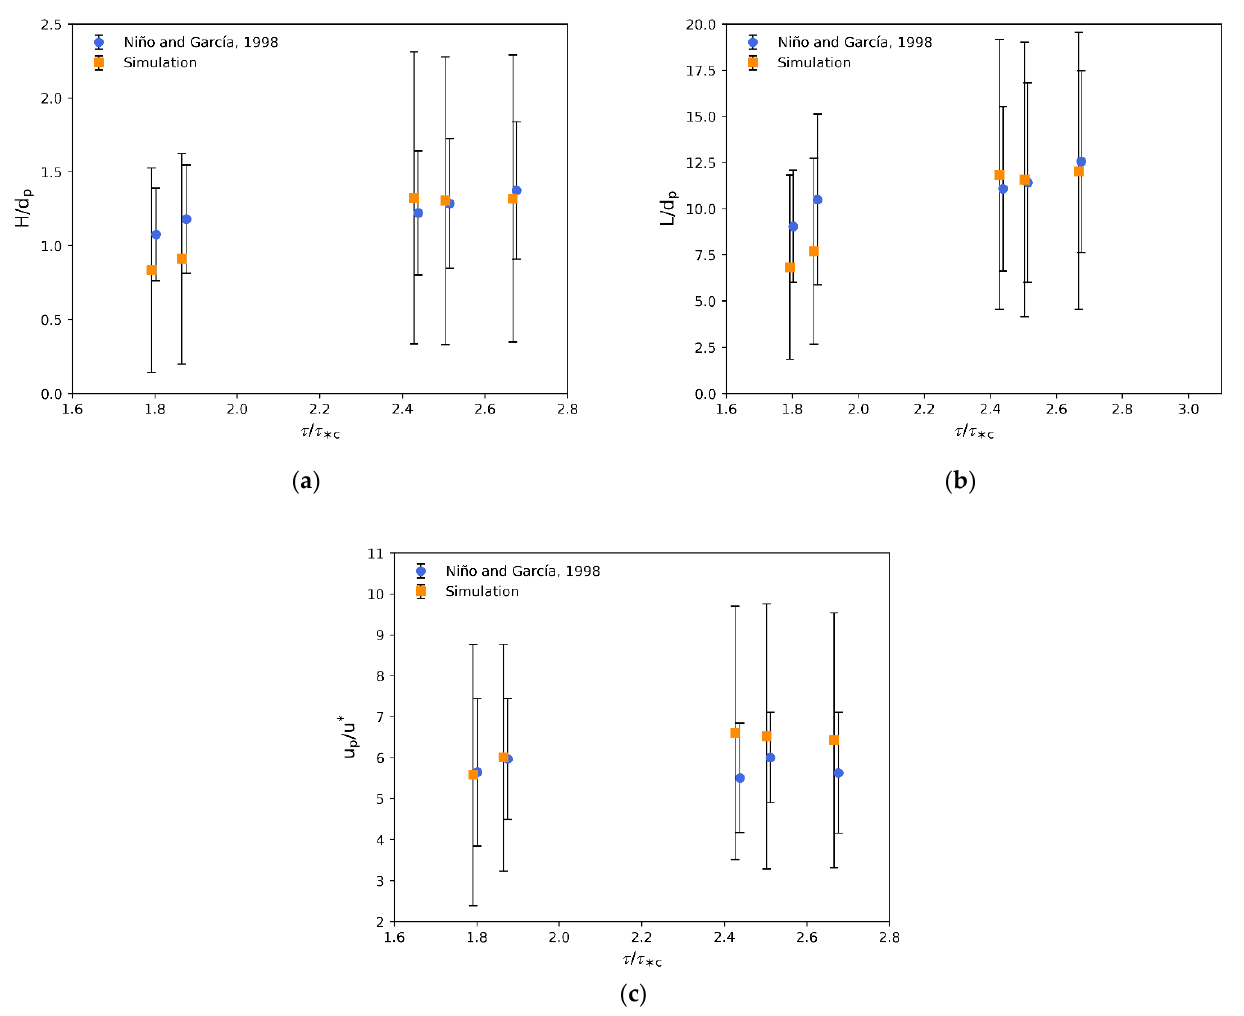
Figure 4. Comparison of simulation results with experimental results from Niño and García (1998) [42]. ( a ) Dimensionless average jump height, ( b ) dimensionless average jump length, and ( c ) dimensionless particle streamwise velocity. Vertical lines indicate two standard deviations.